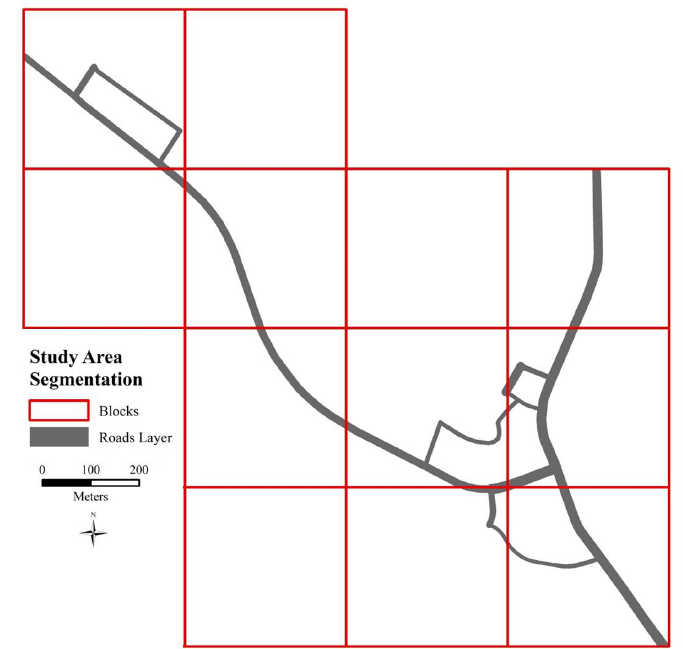
Figure 2. The study area segmented into 14 discrete blocks for the creation of manageable datasets. Blocks were generated using the Place Fence tool in